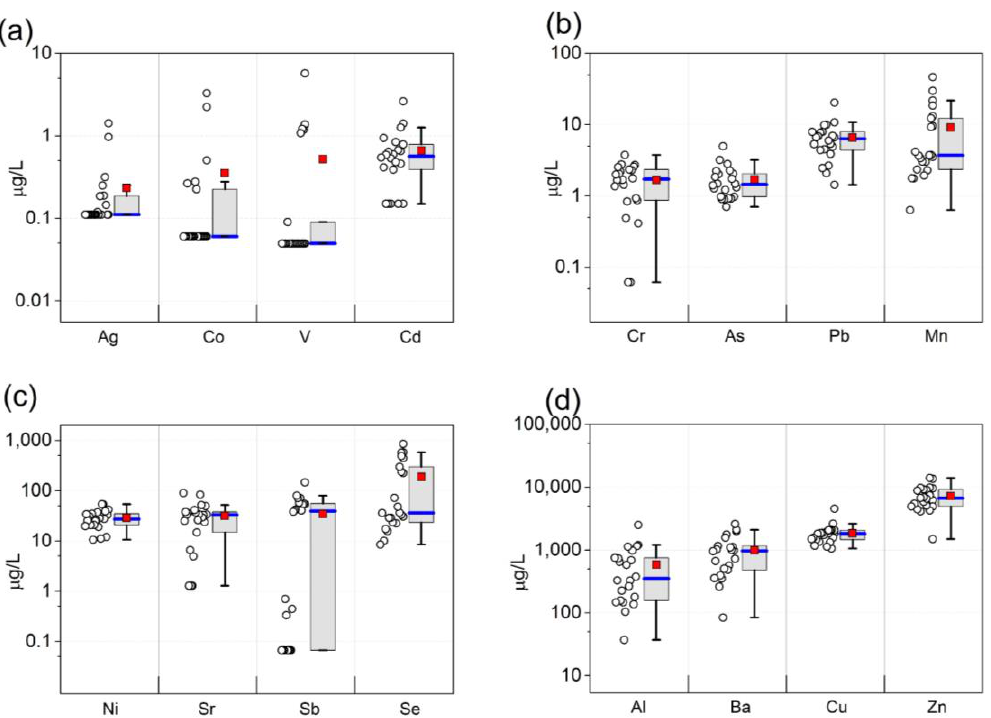
Figure 2. Distribution of metals in the whole blood of 22 pregnant women attending a primarily Medicaid-serving prenatal clinic in Houston, Texas, 2015–2016. Each data point represents an individual metal concentration value in blood. Red squares represent mean concentrations and blue lines represent median concentrations: ( a ) Ag, Co, V, and Cd concentrations in whole blood; ( b ) Cr, As, Pb, and Mn concentrations in whole blood; ( c ) Ni, Sr, Sb, and Se concentrations in whole blood; ( d ) Al, Ba, Cu, and Zn concentrations in whole blood.